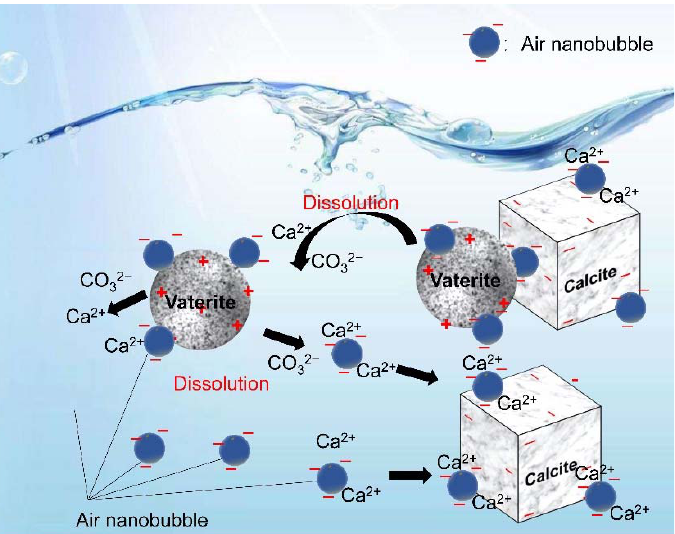
Figure 16. The interaction between nanobubble, vaterite, and calcite and transformation from va ‐ terite to calcite. (Ca 2+ concentration 10 − 4 to 10 − 6 M, pH = 10, vaterite mean diameter 5 μ m, air nano ‐ bubble 120 nm.).